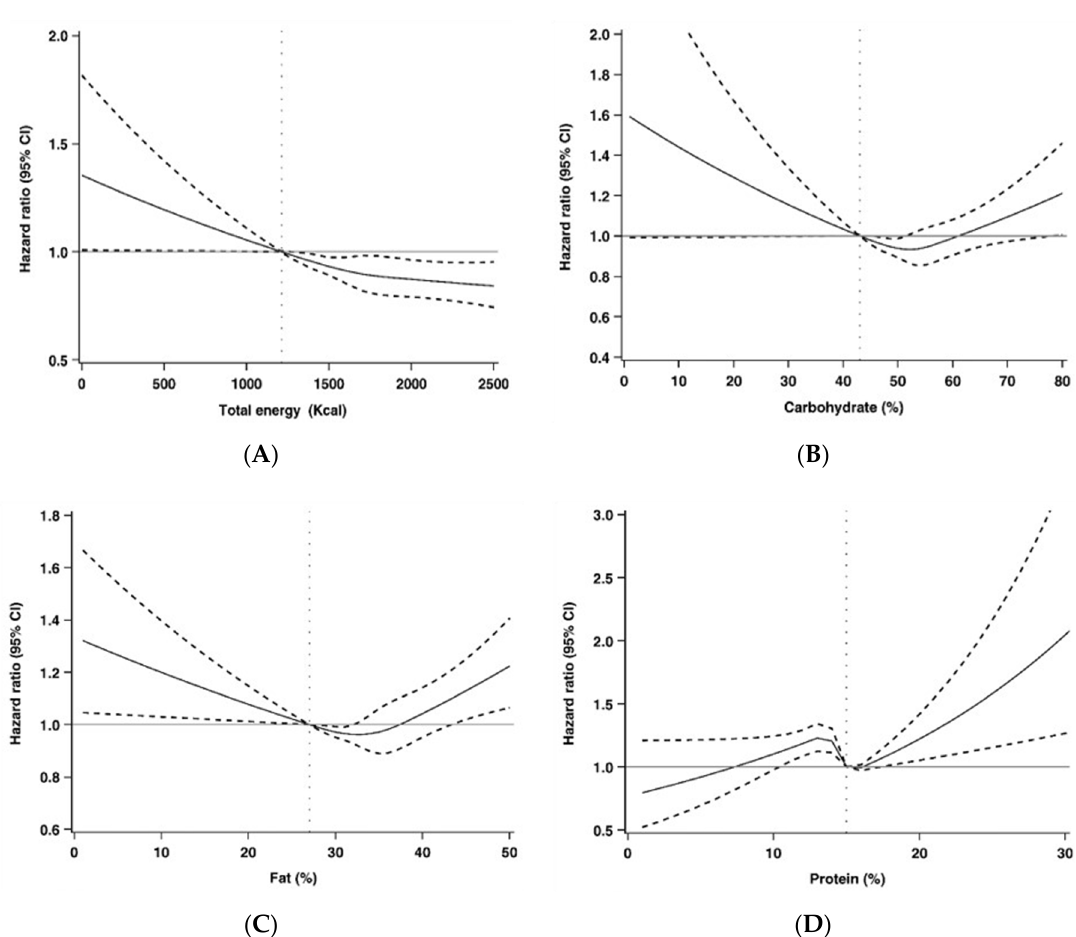
Figure 3. Restricted multivariable cubic spline plots for ( A ) total energy, ( B ) carbohydrate, ( C ) fat and ( D ) protein and all-cause mortality. CI: confidence interval.